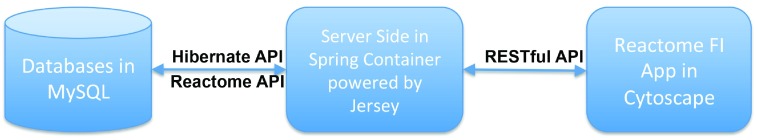
The three-tier software architecture used to implement ReactomeFIViz.